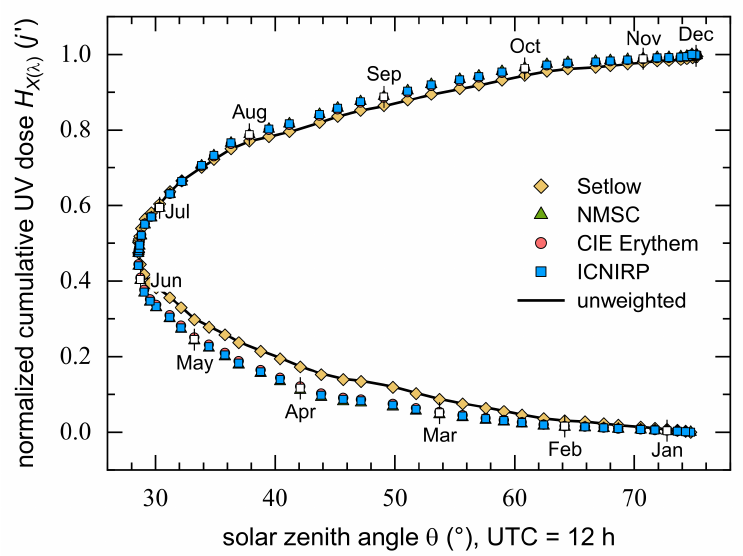
Figure 4. Normalized (31 December) cumulative UV doses, H X ( λ ) ( j (cid:48) ) , calculated for 2018 according to Equation (2) with the Setlow, NMSC, CIE, and ICNIRP action spectra presented in Figure 1, and shown as a function of SZA, determined for UTC = 12 h, in the course of the year. The solid line represents the normalized radiometric (unweighted) annual UV dose. White symbols highlighted by vertical dashes mark the 15th of each